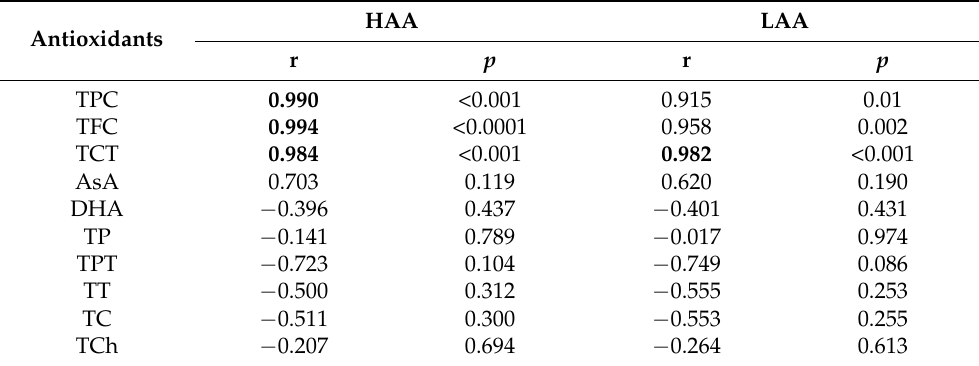
Table 4. Pearson’s correlation for antioxidant activities (TEAC method) versus antioxidant com- pounds. n (sample size) = 5. Values in bold are significant.